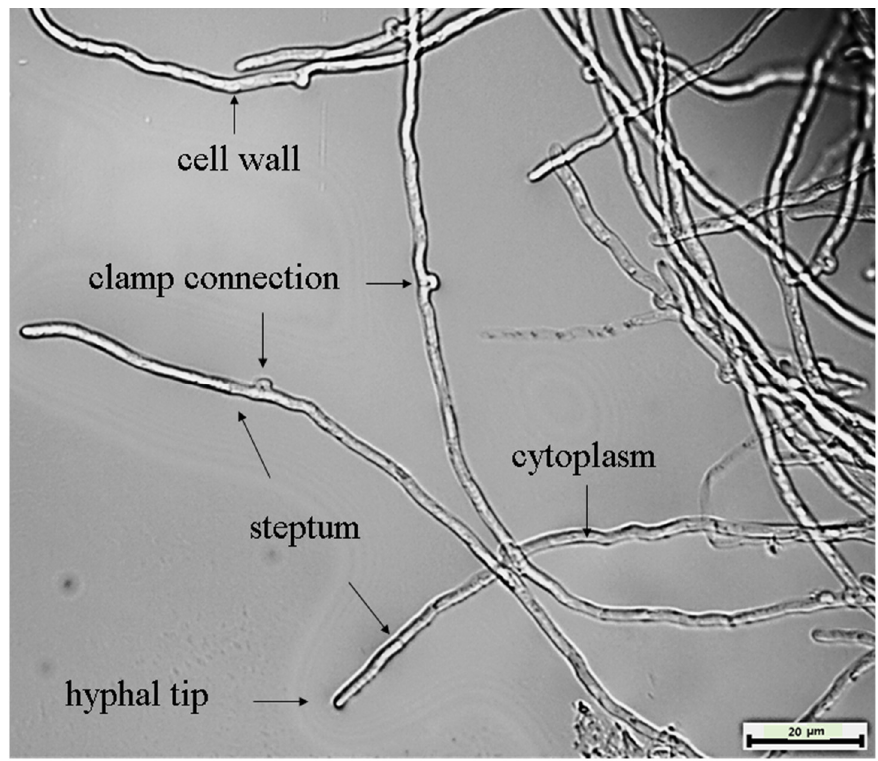
Figure 1. Cellular morphology of SP02 hypha (magnification 10 × 100) from liquid nutrient medium inoculated SP02 at 28 °C for 5 days.